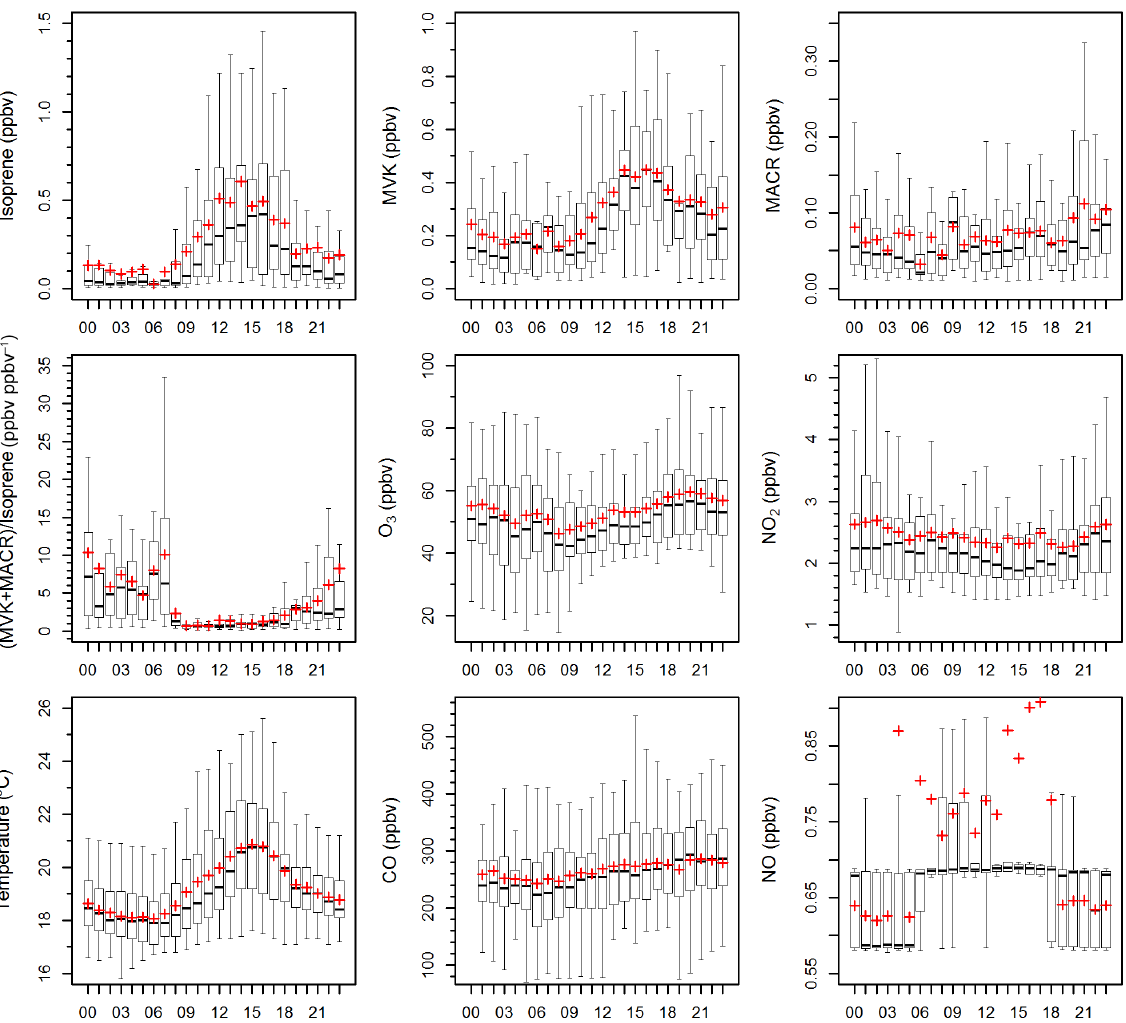
Figure 3. Box and whisker plots of average diurnal patterns of observed isoprene, MVK, MACR, (MVK + MACR) / isoprene ratios, O 3 , NO 2 , temperature, CO and NO. The x axis is “hour of day”. The black thick line and red plus sign represent the median and mean value,